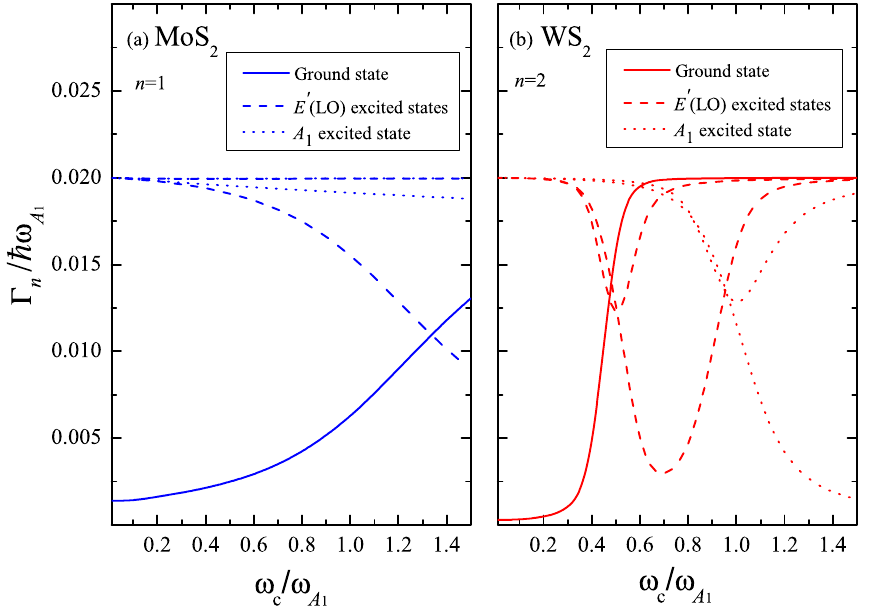
Figure 5. Life-time broadening (in units of (cid:31) ω A 1 ) vs the relative cyclotron frequency ω c /ω A 1 for the quantum level n = 1 ( n = 2 ) in MoS 2 (WS 2 ). Solid line corresponds to the ground-state polaron level. Dashed and dotted lines represent the first two excited states for the LO and A 1 -homopolar modes, respectively.